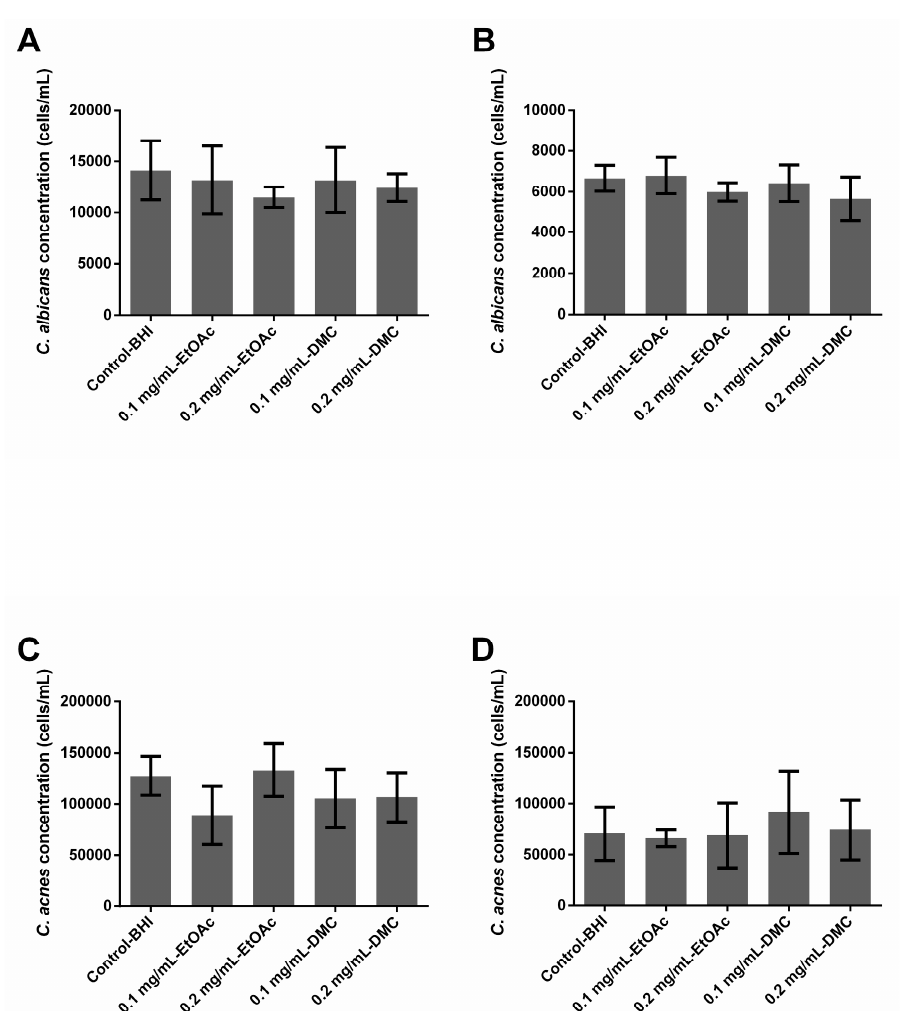
Figure 2. Ability of Arthrospira fusiformis extracts to eradicate preformed biofilm.